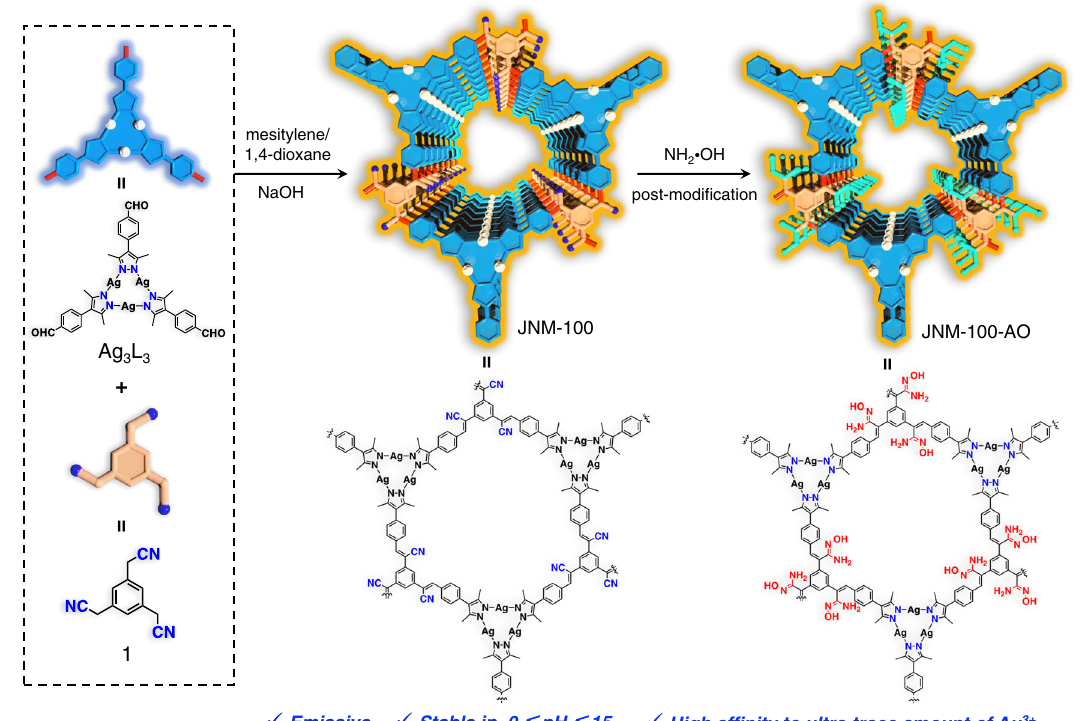
Fig.1|FabricationandchemicalstructuresofJNM-100andJNM-100-AO. Left:TheschematicrepresentationandchemicalstructureofAg 3 L 3 andorganiclinker1.Right: the schematic illustration and chemical structure of JNM-100 and